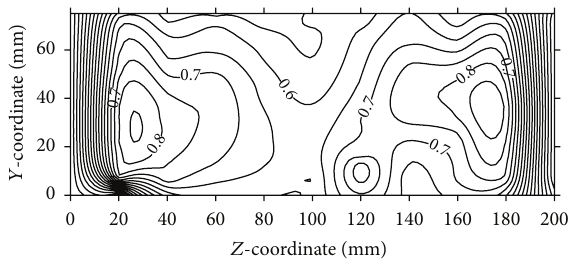
Figure 10: Normalized velocity contours at the outlet for air-intake (best VGJ case). Table 4: Performance comparison of air-intake using flow control. Flow